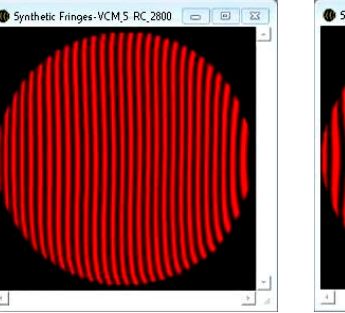
Figure 17. He ‐ Ne interferograms of tulip ‐ like VCM#5 without over ‐ thickness at the central tip. Curvature variation from f /100, f /15, f /8.2 to f /5 ( left to right ) for a 14 mm clear aperture diameter. Curvature radii RC = 2800, 420, 230 and 140 mm, respectively. A realization by use of modeling from Table 1, i.e., including an over ‐ thickness at the tip– should avoid present local deviation errors near the center.